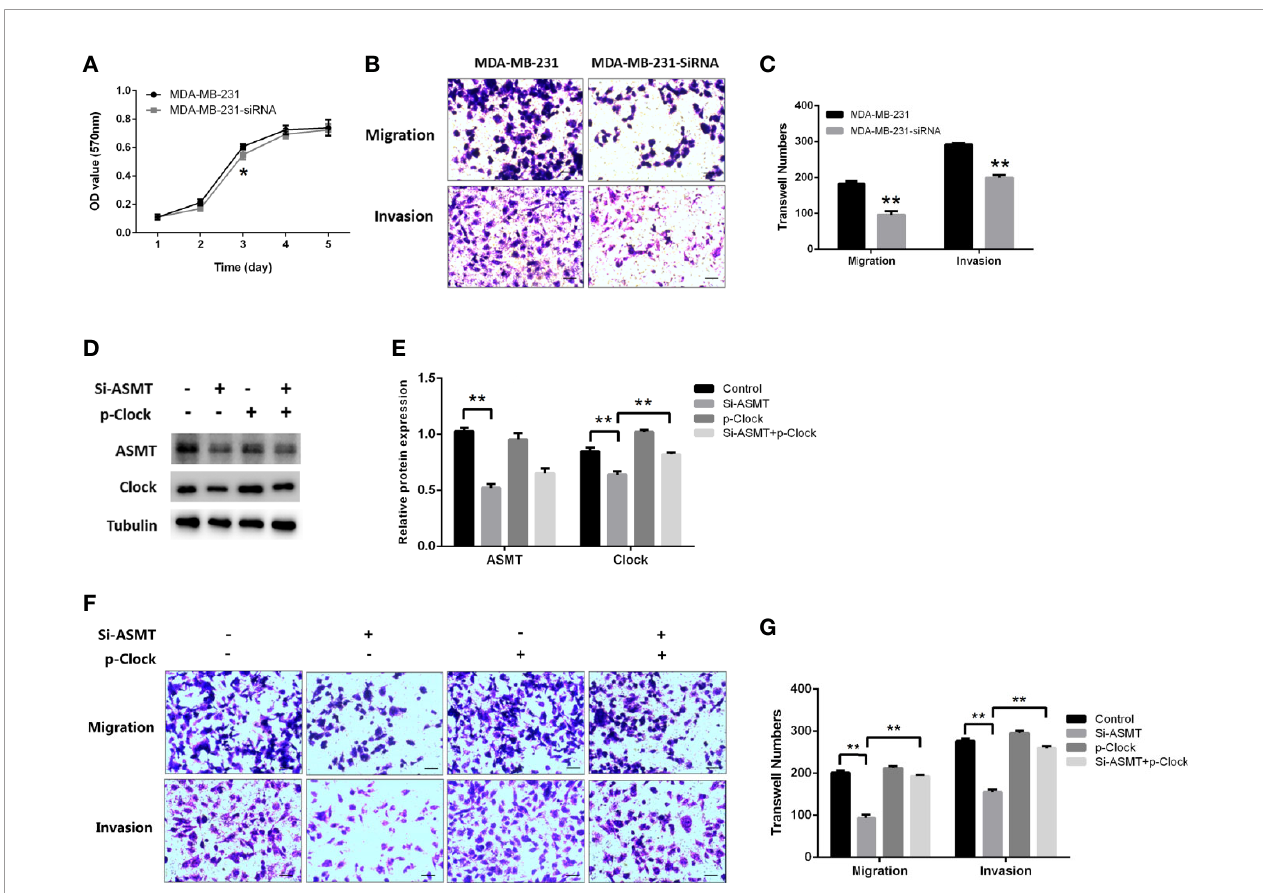
FIGURE 6 | Inhibition of ASMT leads to reductions in migration and invasion by downregulating clock expression in MDA-MB-231 cells. (A) Cell proliferation following the loss of ASMT expression as measured by MTT assay. Data are the mean ± SEM (n=8). (B, C) Representative images and counts of cells migration and invasion following ASMT-SiRNA transfection. Cells were fi xed with 4% paraformaldehyde, stained with 0.5% crystal violet, and counted under microscope. Scale bar=100 m m. Data are the mean ± SEM (n=8). (D, E) Expressions and quanti fi cations of ASMT and CLOCK measured by Western blotting. Tubulin was used as an internal control for protein quanti fi cation. Data are the mean ± SEM (n=3). (F, G) Representative images and counts of cells migration and invasion following ASMT- SiRNA and CLOCK plasmid DNA cotransfection. Scale bar = 100 µm. Data are the mean ± SEM (n = 8). ** p <